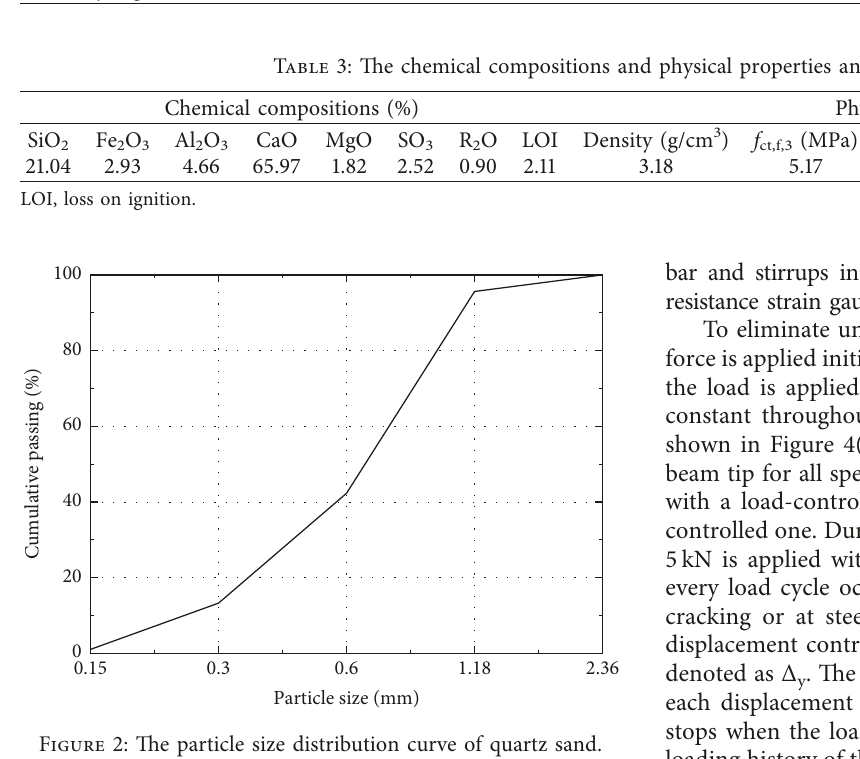
Figure 2: The particle size distribution curve of quartz